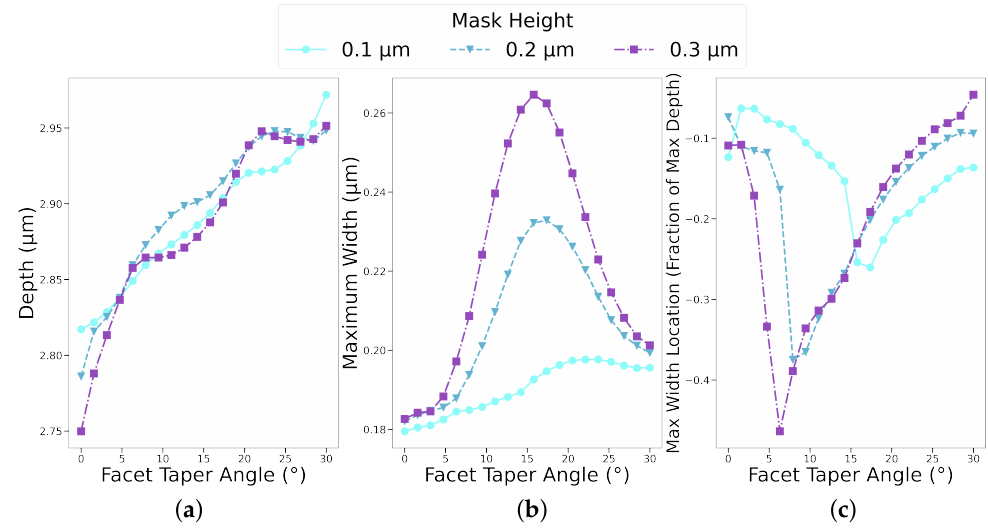
Figure 9. Depth, maximum width, and its location down the feature sidewall for thin mask faceting. In ( a ), the maximum depth increases with increasing the tapering angle. In ( b ), bowing is at its maximum for angles between 15° and 20° while being less pronounced for the thinnest considered mask of 0.1 µ m due to a reduced ion reflection surface. The location of the maximum width ( c ) jumps from just under the mask towards the bottom of the profile and approaches the mask again for higher